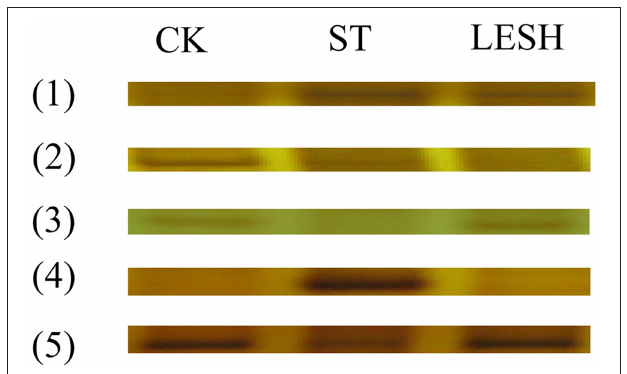
FIGURE 2 | The results of selective amplification. CK, Control; ST, shade treatment; LESH, light exposure after shade removal. The differentially expressed bands were divided into five groups: (1) expressed during shade treatment (ST) and during light exposure after shade removal (LESH) but not in the control (CK); (2) expressed in ST and CK but not LESH; (3) expressed in CK and LESH but not ST; (4) expressed in ST but not CK and LESH; and (5) expressed in ST, LESH and CK at different